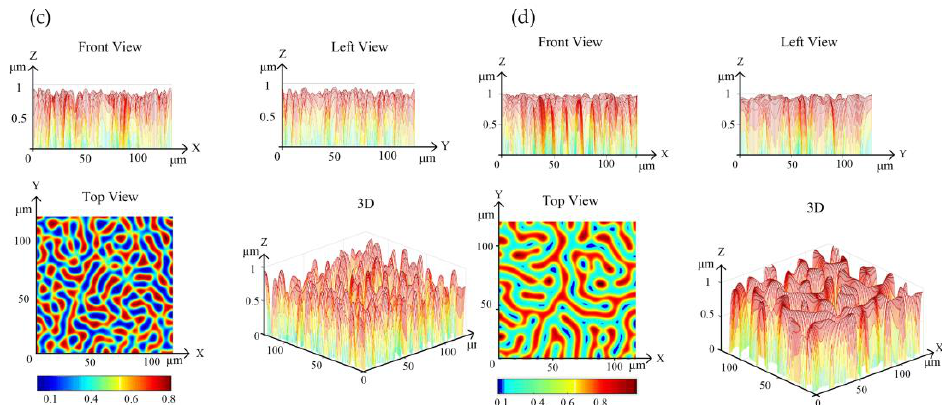
Figure 2. Micrograph and abrasives energy diagram. ( a ) t = 30 min, ( b ) t = 60 min, ( c ) t = 120 min, and ( d ) t = 240 min. Table 2. Taguchi L25(54): array design.